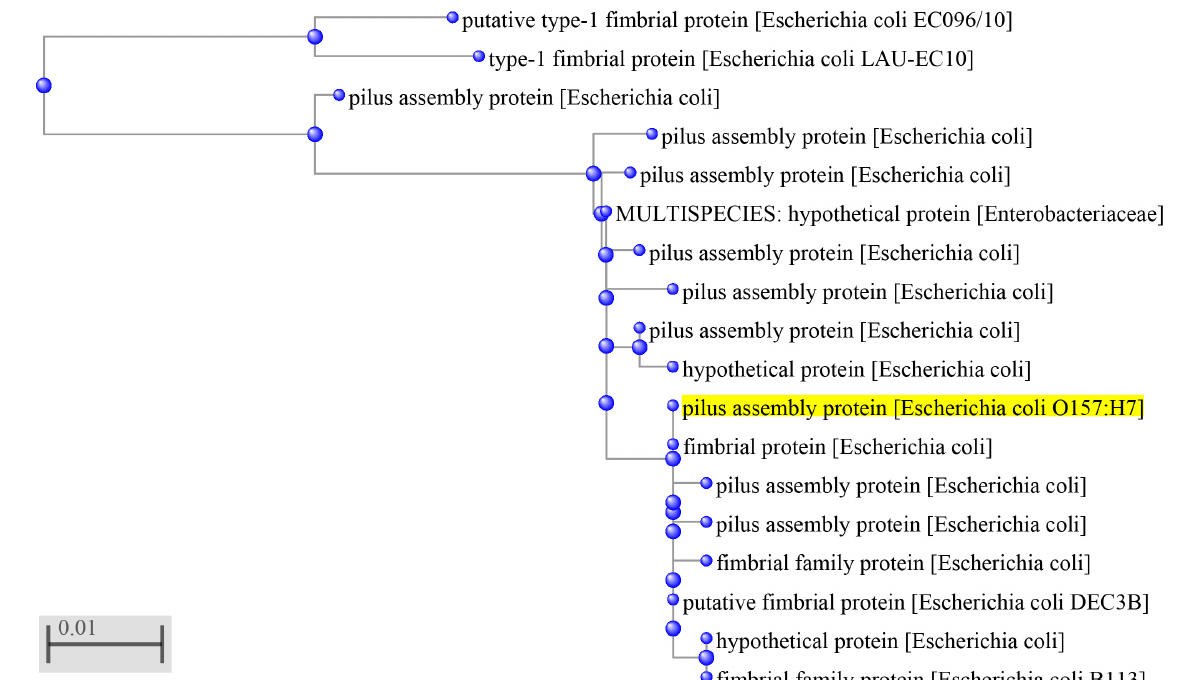
Frontiers in Microbiology |